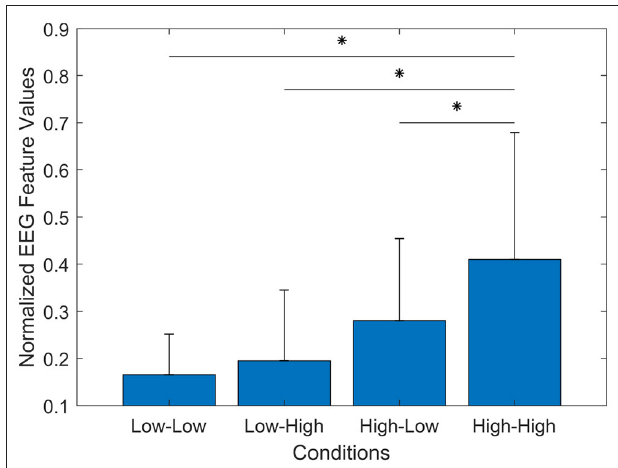
FIGURE 11 | The bar graph represents the mean and standard deviation of the proposed set of EEG features. The Wilcoxon test showed a significant increase of workload the Low-Low and High-High ( p = 0.000), the High-High and Low-High ( p = 0.005), and the High-High and High-Low ( p = 0.000) conditions. ∗ p <